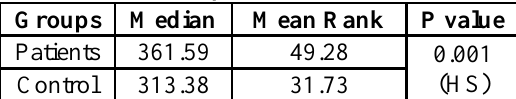
Table 2: The median and mean rank difference of serum ACA (ng/ml) in SSc patients.